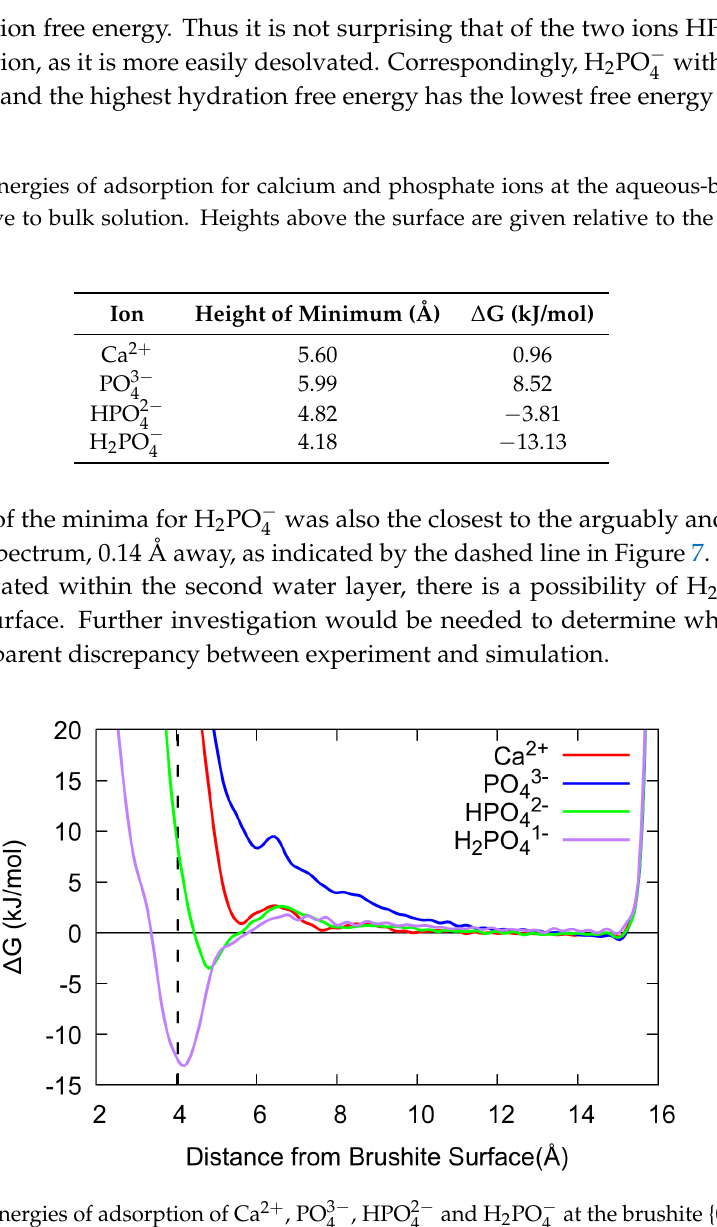
, HPO 2 − and H 2 PO − at the brushite {010}-aqueous 4 4 4